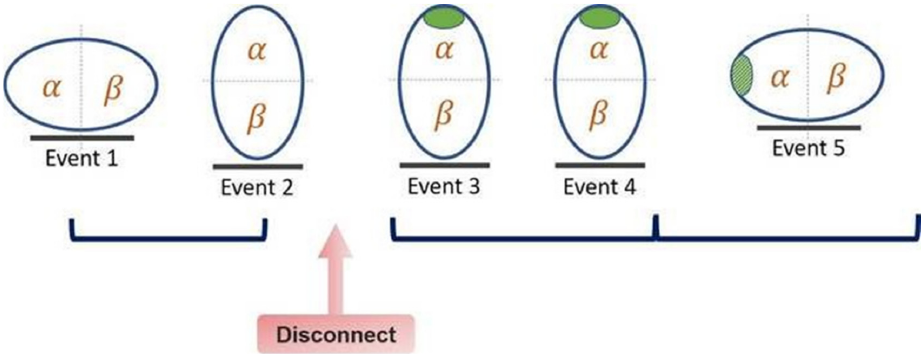
Figure 2. EIT measurement protocol at five different time points. Supine position prior to surgery (event 1); lateral decubitus position prior to surgery (event 2); lateral decubitus position during surgery (standard VATS procedure with iatrogenic pneumothorax) (event 3); lateral decubitus position during surgery (standard VATS procedure without iatrogenic pneumothorax) (event 4); and supine position after surgery (event 5).